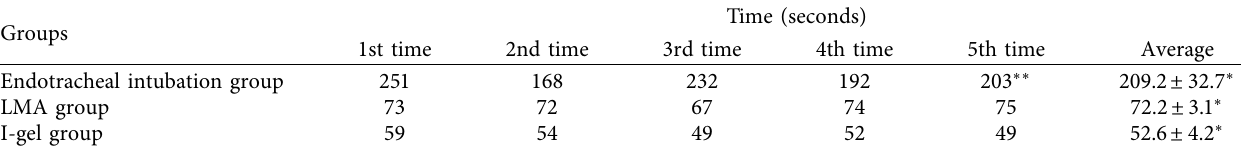
Table 1: Operation time of each